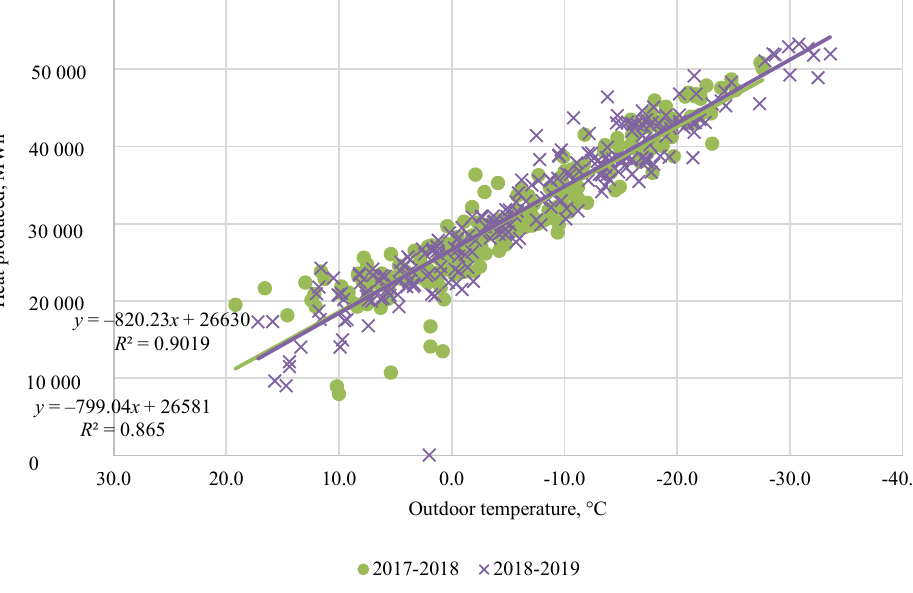
Fig. 7. Regression analyses of correlation between outdoor temperature and amount of heat produced. We found correlation between outside temperature and supply/return